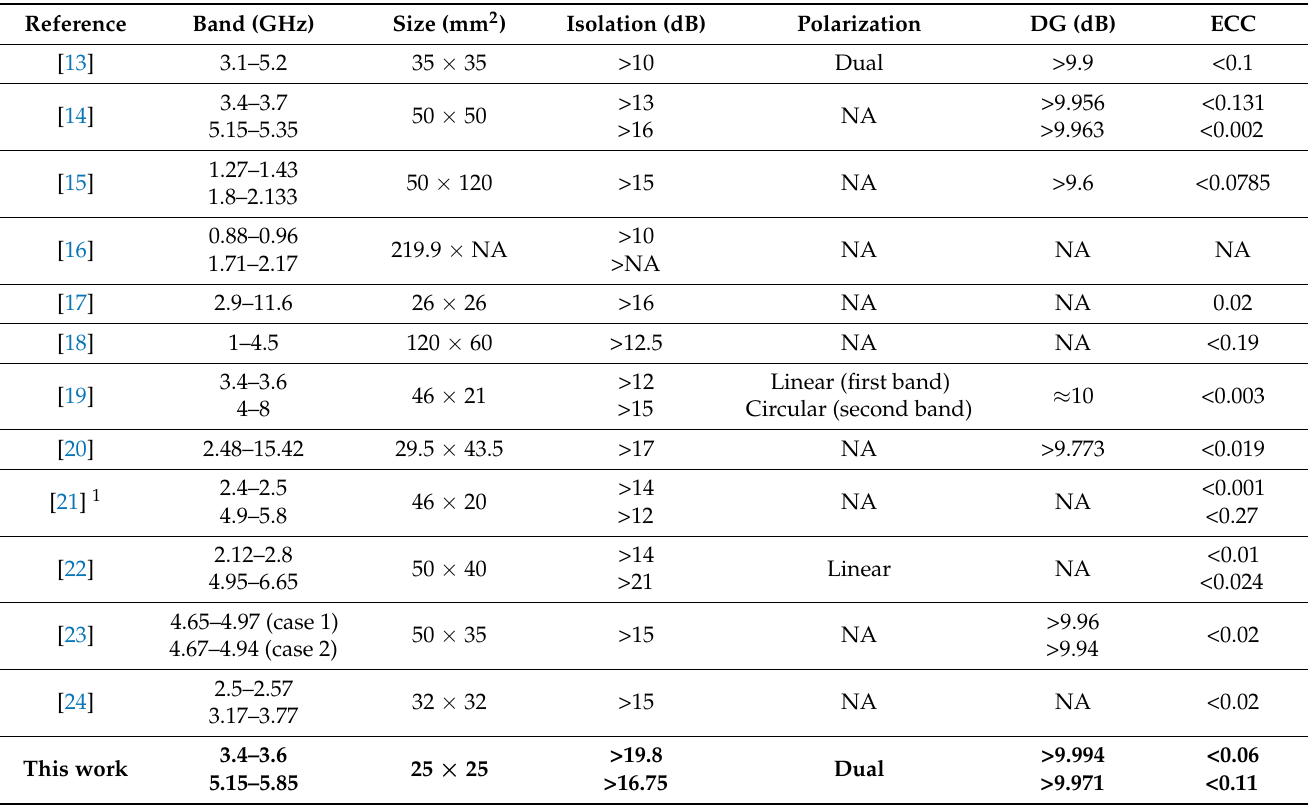
Table 1. Comparison between the proposed work and the referenced two-element MIMO